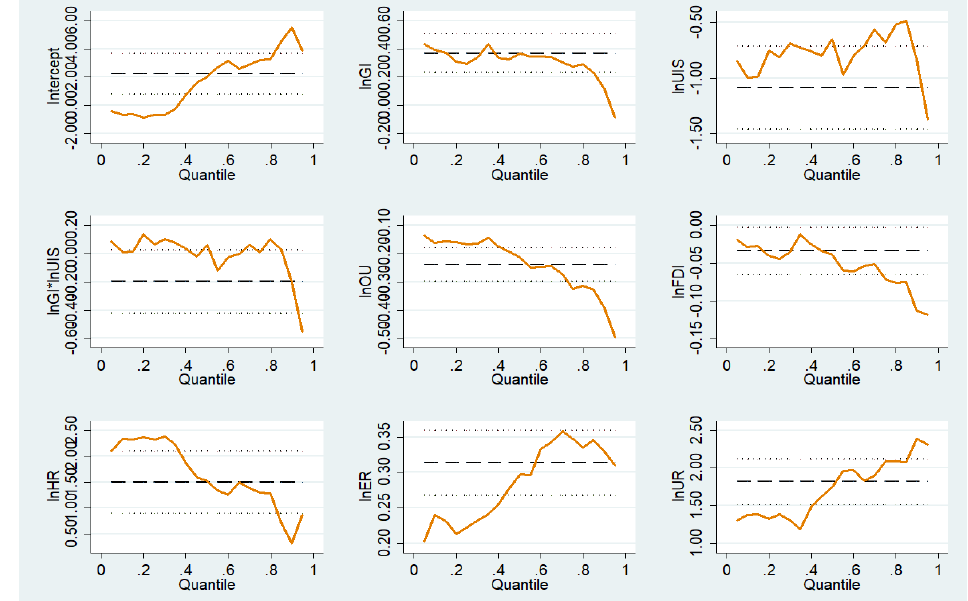
Figure 2. Variation in the quantile regression coefficient of each factor.